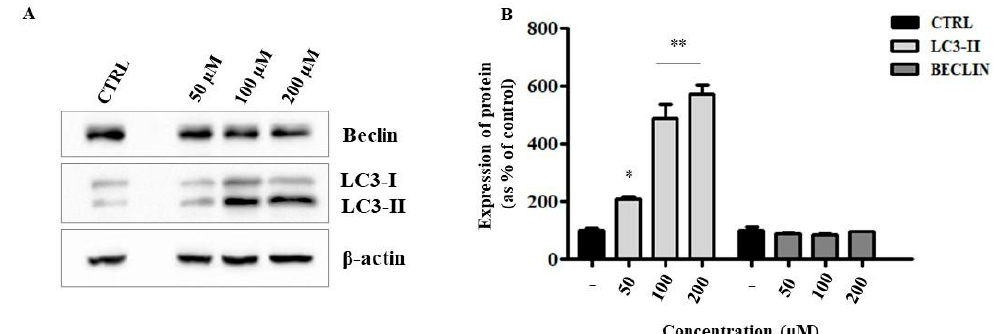
Figure 8. Evaluation of expression levels of autophagy-related proteins. Representative Western blot images ( A ) and relative densitometric analyses ( B ) performed on the lysates of HepG2 cells treated with the indicated concentrations of liposomal ANP0903. β -actin was used as a loading control. Protein levels were presented as the fold change relative to control cells (CTRL). Data are expressed as means ± Standard Error (SE) of three independent experiments and statistical significance was evaluated with Kruskal–Wallis test (* p < 0.05, ** p < 0.01 vs. CTRL).